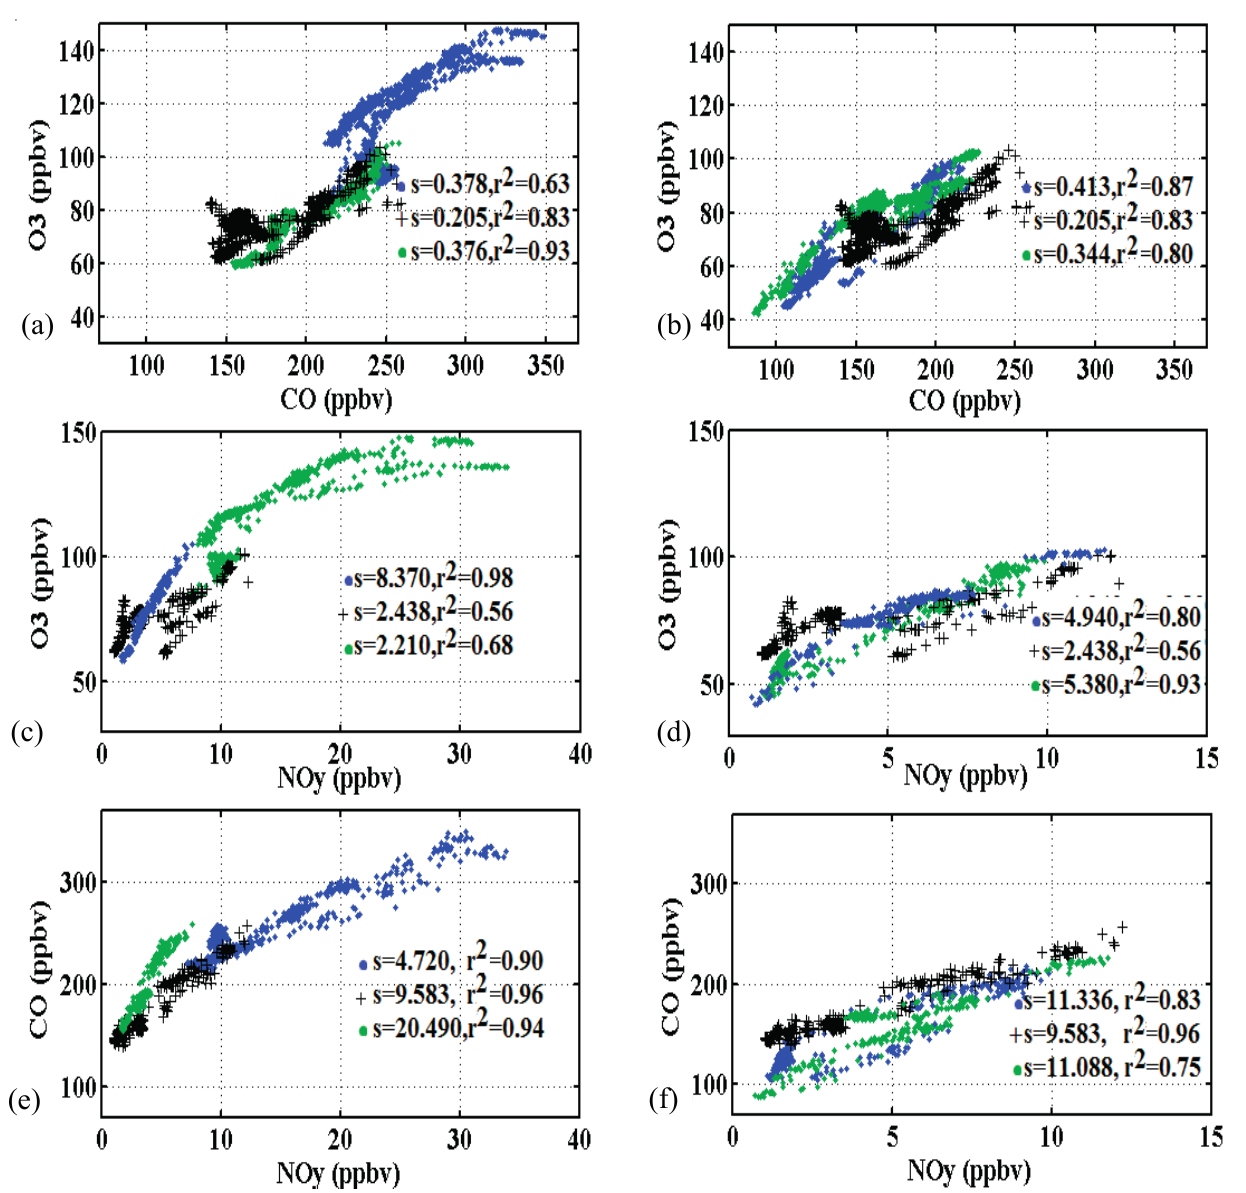
Figure 5. Selected trace gas relationships with the plume layer and parameters for corresponding linear fits. Shown in ( a ) and ( b ) are O 3 /CO observations by P3 aircraft over the coastal ocean GOM regions respectively. Observations of O 3 /NOy over the ( c ) coastal and ( d ) open ocean are also shown. Corresponding observed CO/NOy over the coastal GOM and open ocean are presented in ( e ) and ( f ). Black marks designate observations within the plume over the NYC source region on 7/20, blue markers designate observations over the GOM on 7/21 and green markers designate observations over the GOM on 7/22 with all values being in